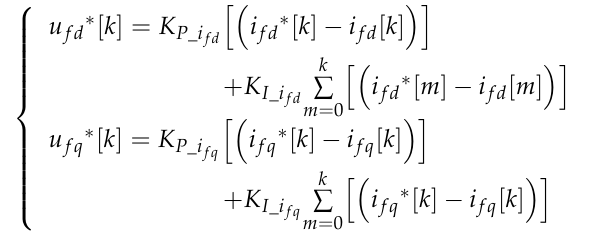
Figure 5. Block diagram of the induction generator control algorithm.